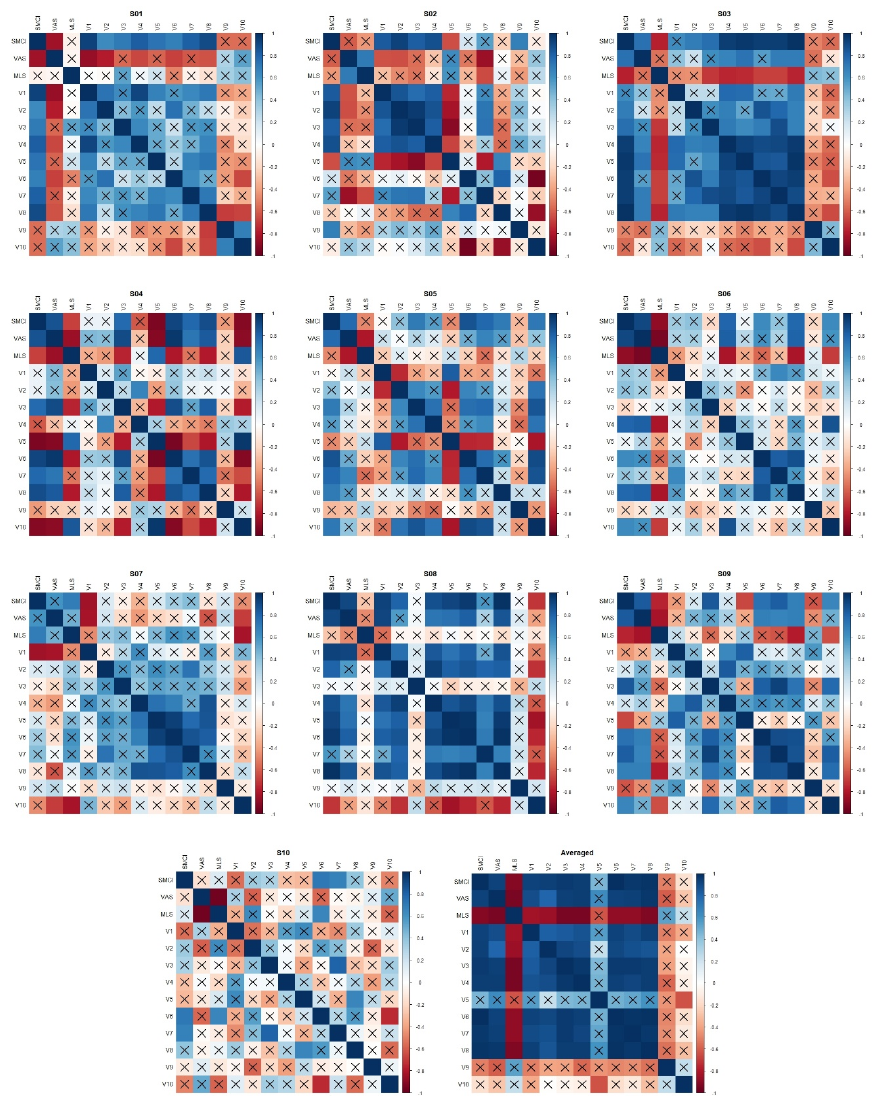
Figure A1. Correlation heat maps for each participant (S01–S10) and across all participants (averaged). The dependent variables are spine motion composite index (SMCI), fatigue visual analogue scale (VAS), maximal lift strength (MLS), and the kinematic variables used in the SMCI: T8 peak orientation (V1); T8 peak angular velocity (V2); T8 peak angular acceleration (V3); T8 orientation range (V4); pelvis peak orientation (V5); pelvis peak angular velocity (V6); pelvis peak angular acceleration (V7); pelvis orientation range (V8); repetition time (V9); and peak thoraco-pelvic continuous relative phase (V10). Correlations between dependent variables were calculated using Pearson’s correlation coefficients across fatiguing sets 1–10, and r values are indicated by the colour bar to the right of each plot. Insignificant correlations are indicated by × with significance set to α = 0.05.